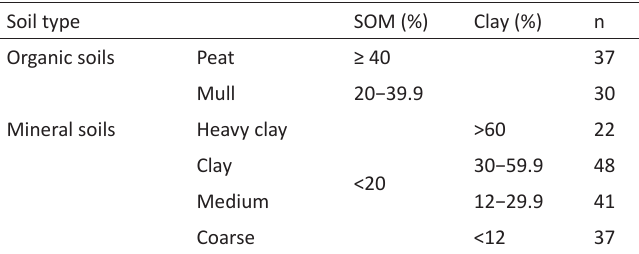
Table 2. Soil classification used in the study based on the soil organic matter (SOM) and clay (<0.002 mm)